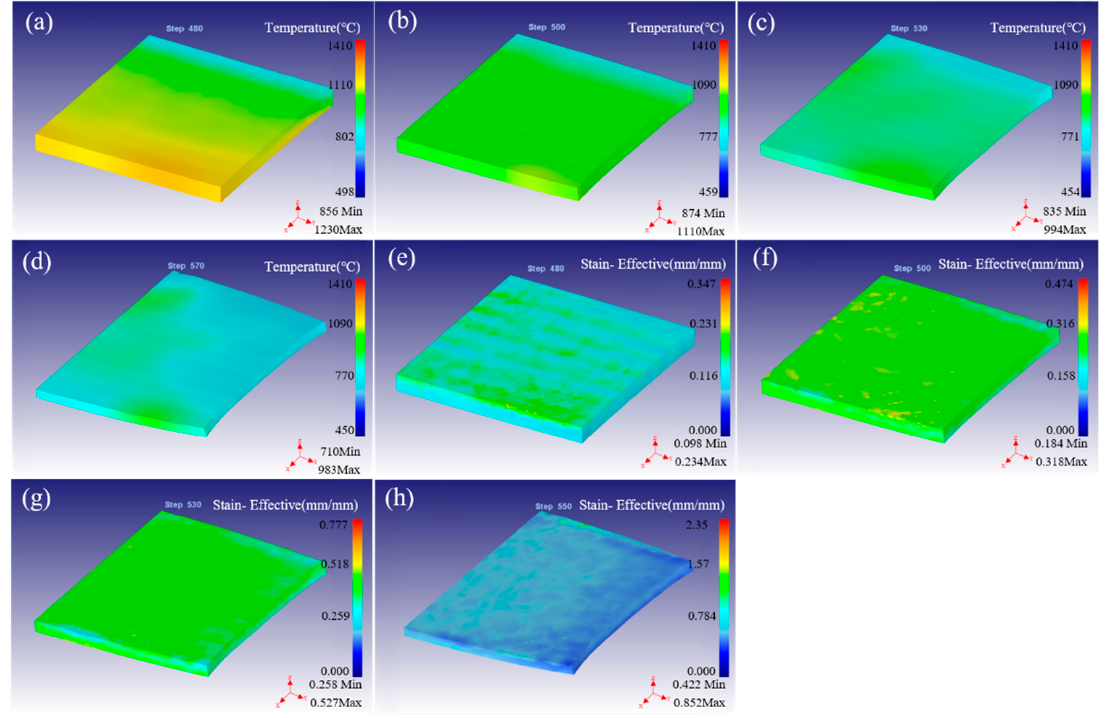
Figure 5. The distribution of temperature field ( a – d ), and strain field ( e – h ) by finite element simulation under different rolling reduction with 10–40%.